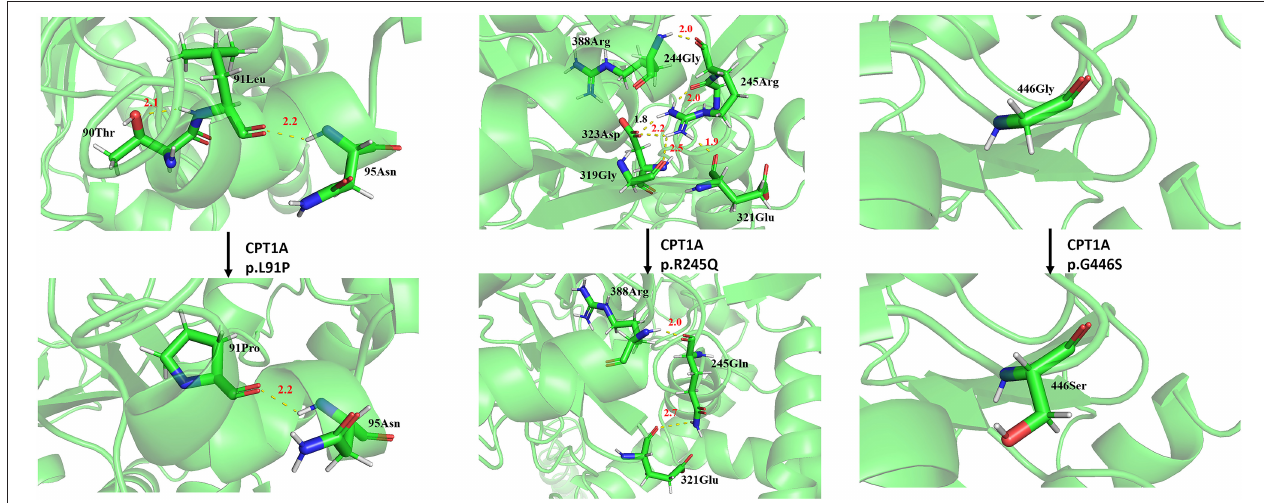
FIGURE 3 | Three-dimensional structural modeling of wild-type and mutant CPT1A proteins. The yellow dashed lines represent hydrogen bonds, and the red numbers represent the hydrogen bond distances. Leu-91 is located in the extracellular segment between two transmembrane domains. The p.L91P variant may affect the quaternary structure of CPT1A by causing the loss of the side chain hydrogen bond with Thr-90, which may result in abnormal folding of CPT1A. p.R245Q is located in the C-terminal catalytic domain, which may affect the quaternary structure of CPT1A by eliminating the side chain hydrogen bonds with Gly-244, Gly-319, and Asp-323, possibly resulting in abnormal folding. p.G446S is located in the C-terminal catalytic domain; the beta turn in the CPT1A secondary structure was changed to a random coil, resulting in an unstable protein.